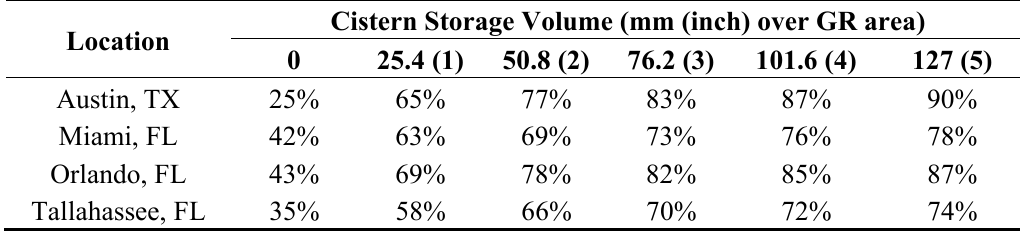
Table 3. Summary of yearly retentions for different cistern storage volumes and locations